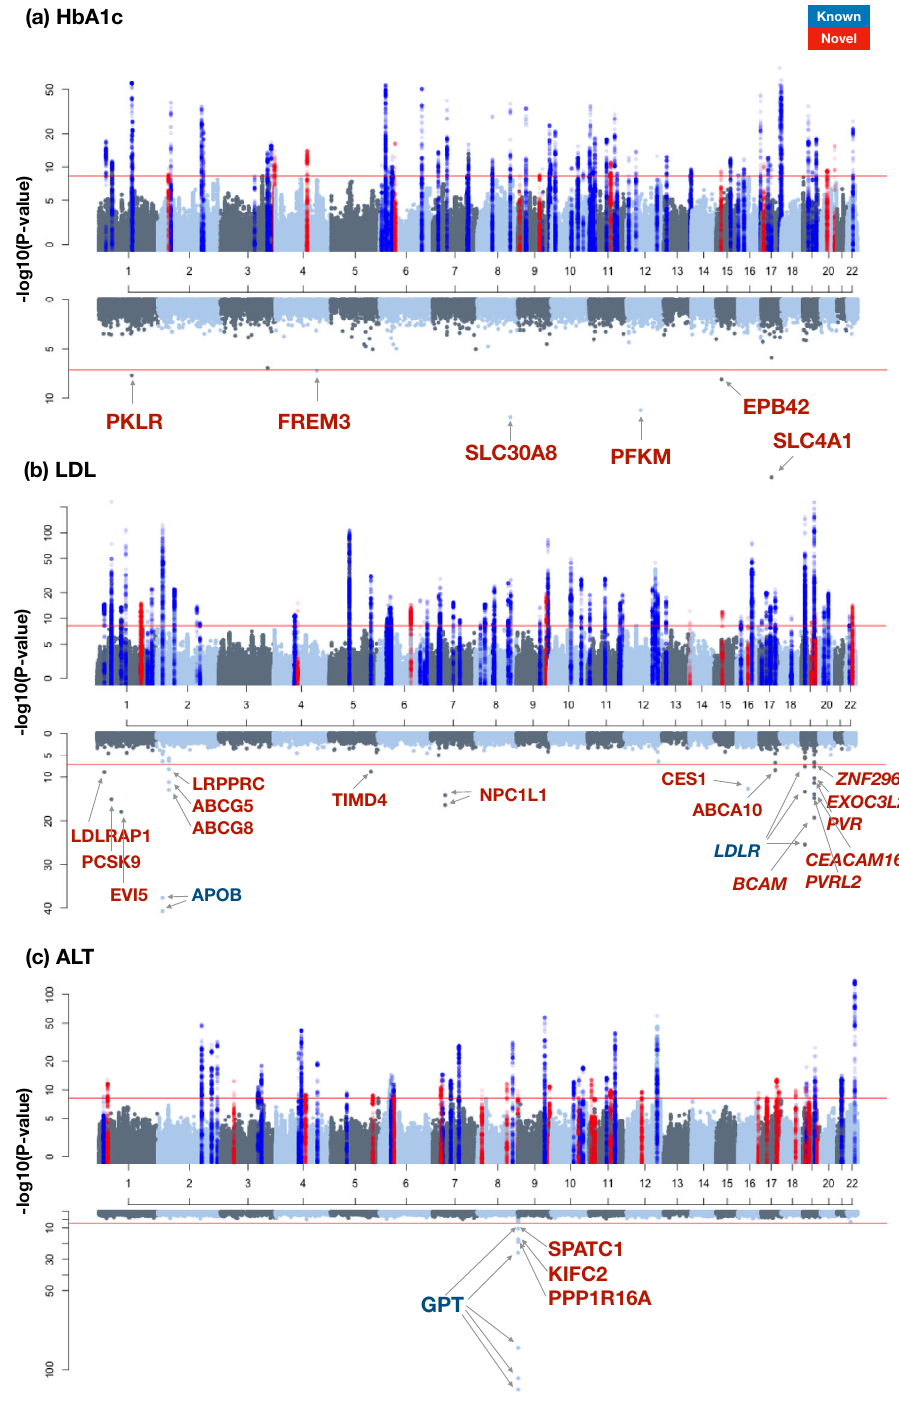
− log10(7.61e-8) for upper and lower panels, respectively. Previously known loci were colored in blue for ±250kb ofthe lead variant and colored in red for ±250kb of new associations of this study. a HbA1c, b LDL, and c